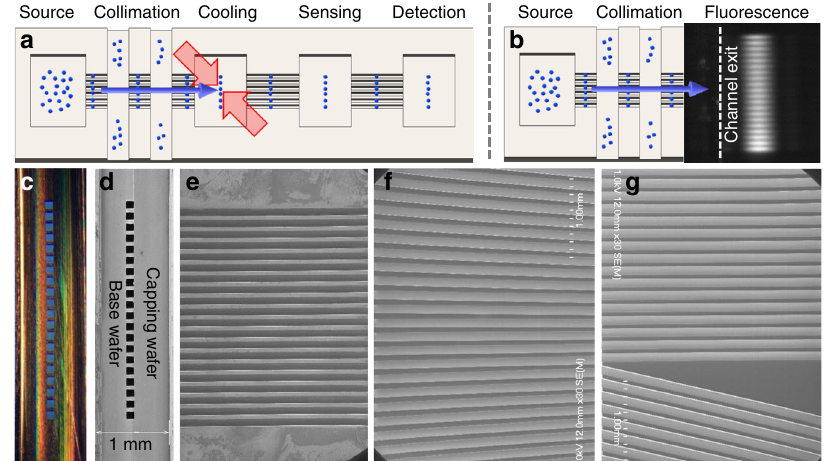
Fig. 1 The planar concept for atomic beams. a In a fully planar vision, atoms propagate from a source region into a planar device that has been lithographically etched into a silicon chip. Shown schematically are multiple sequential operations including beam formation by collimation, laser deceleration and/or cooling, atom interferometry or other sensing protocols using guided atoms, followed by detection. Blue arrows indicate the direction of the atomic beam propagation. b Rubidium atom beam collimation as the fi rst nontrivial element demonstrated in this work. Adjacent image shows the experimentally observed fl uorescence output of 20 individually resolved collimation channels. c Optical and d scanning electron micrograph (SEM) end images of the channels show the etched base wafer and sealing capping wafer. e – g SEM top images before bonding the capping wafer showing microchannels that ( e ) collimated the atomic beam, f produced a focusing beam, and g created two beams propagating at a relative angle of 12 degrees. Channel dimensions in e were 100 × 10 × 3 mm ( h × w × l ) dimension, with 50 μ m wall thickness between channels. Wall thicknesses as small as 10 μ m were fabricated. In all cases high fl ux, effusive Rb atomic beams were successfully